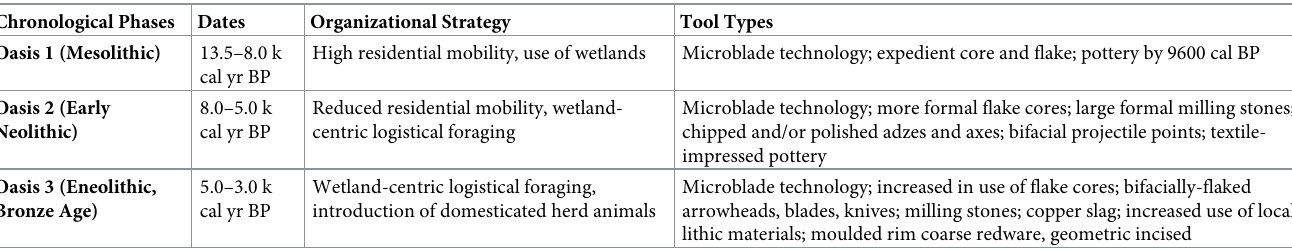
Table 1. Summary of chronological phases and associated